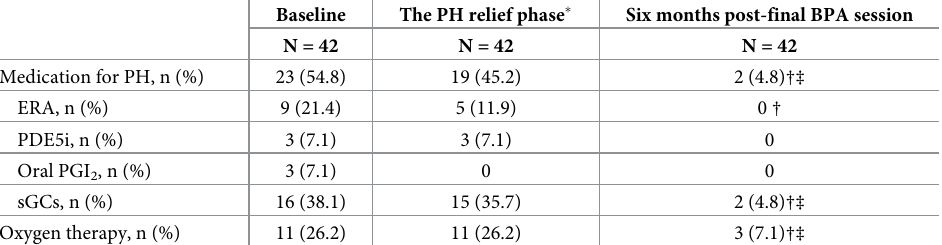
Table 3. Pulmonary vasodilators and oxygen therapy at baseline, at the pulmonary hypertension relief phase, and at 6 months post-final balloon pulmonary angioplasty. Baseline The PH relief phase � Six months post-final BPA session